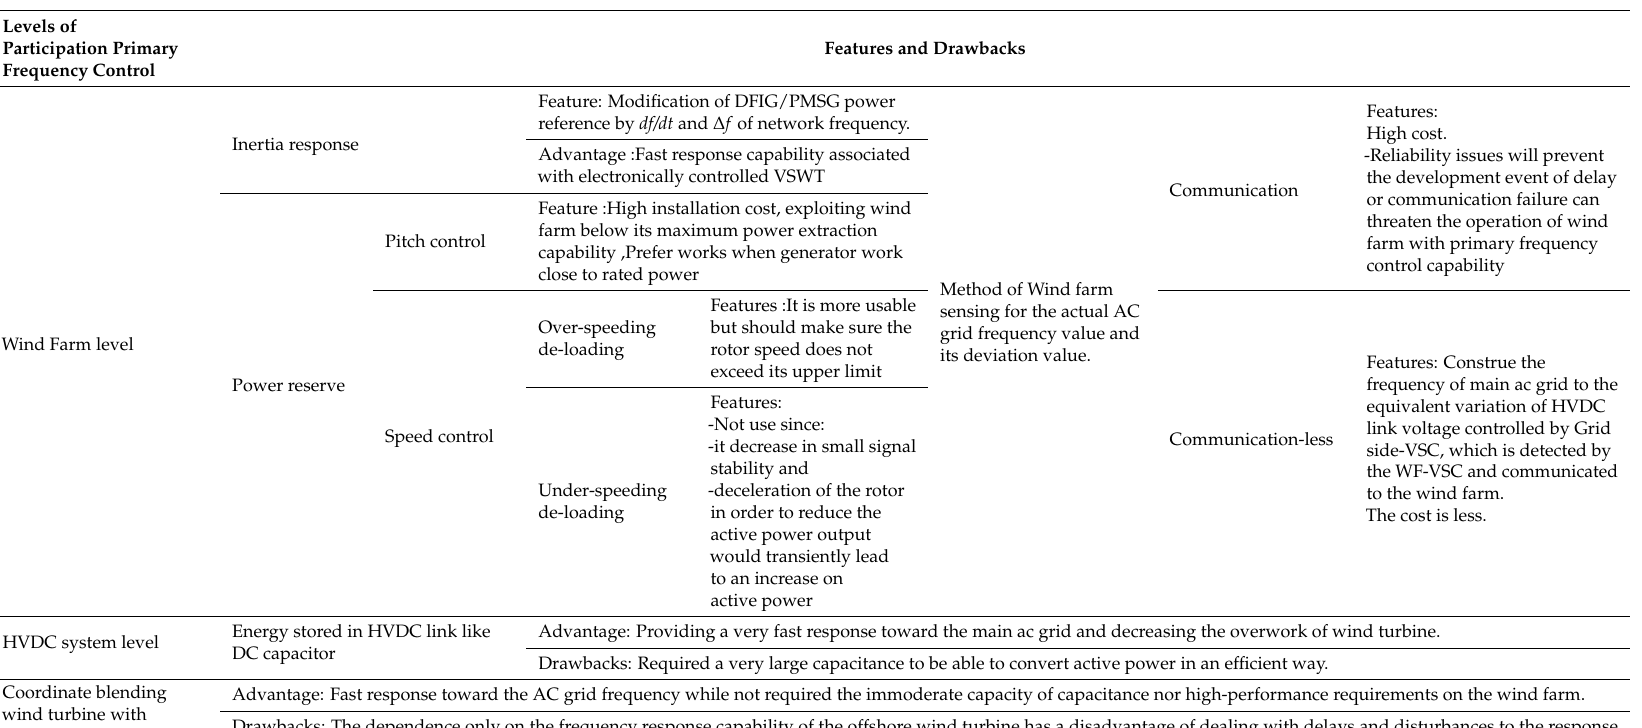
Table 4. Summary of frequency regulation strategies in grid integrated offshore wind turbines via VSC-HVDC